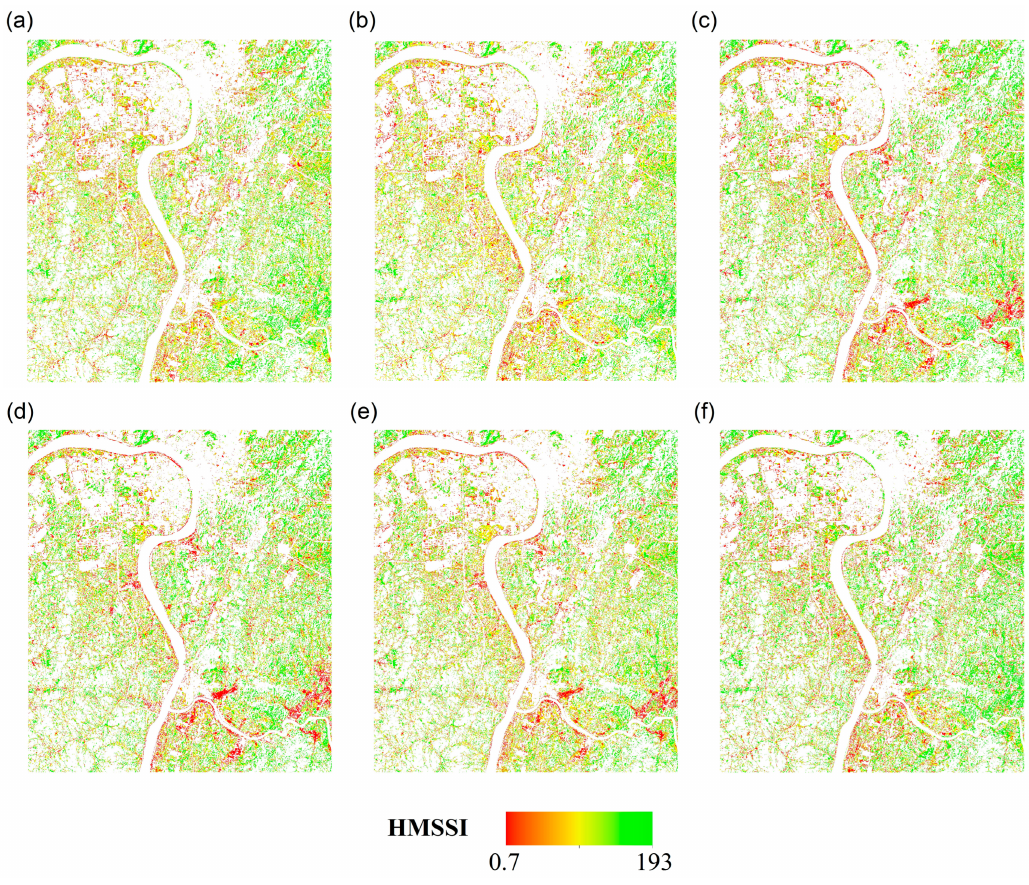
Figure 5. Spatial distributions of HMSSI at different growth stages. ( a , b ) Booting stage; ( c , d ) flowering stage; ( e , f ) mature